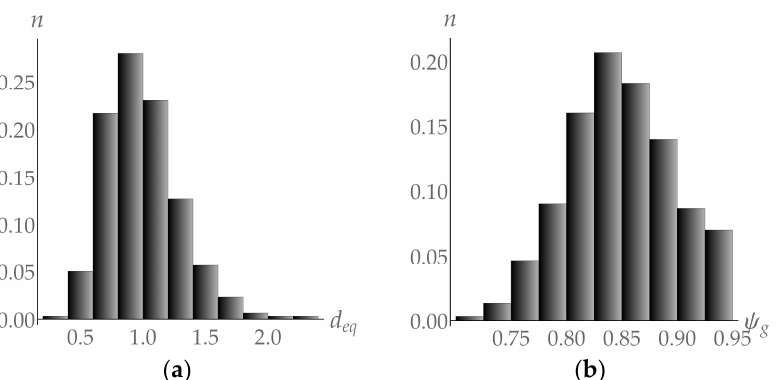
d (non-dimensional) ( a ) and grain sphericity ψ eq